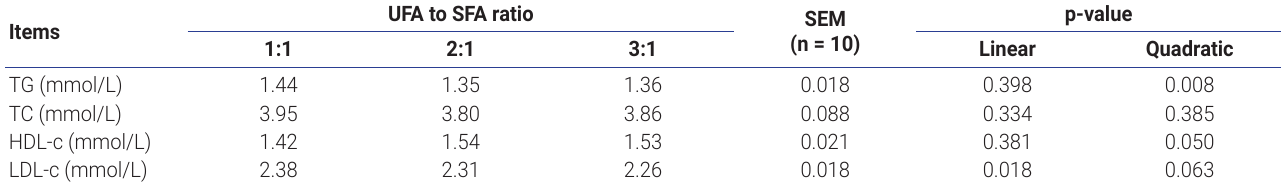
Table 4. Effects of dietary unsaturated to saturated fatty acids ratios on serum lipid parameters of finishing